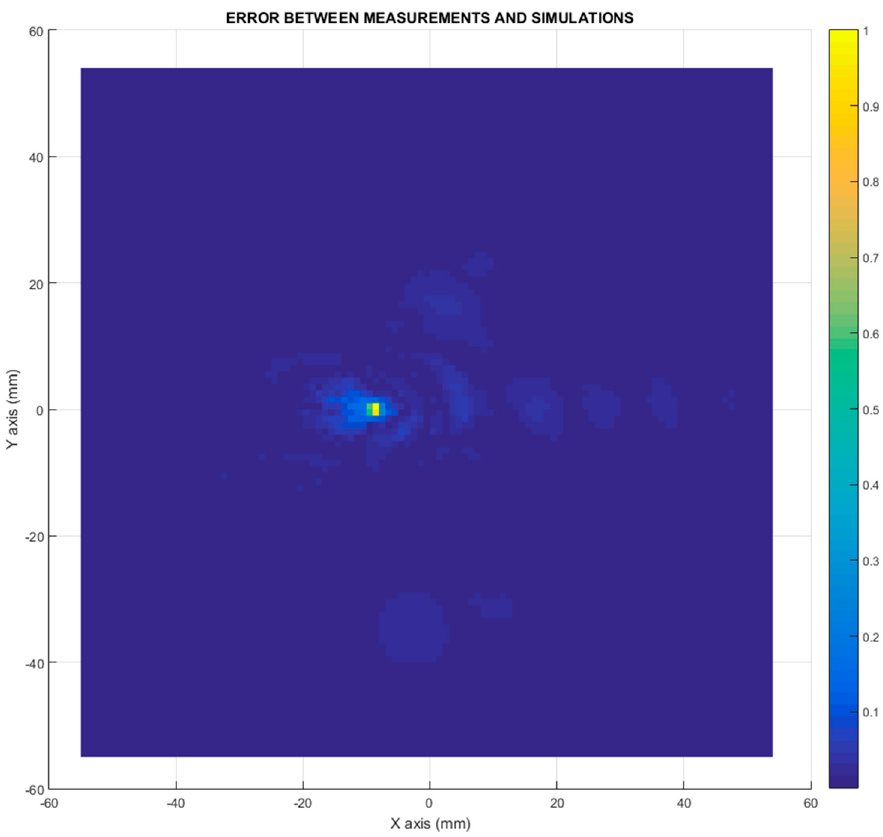
Figure 12. Error between the differential imaging measurement and the differential imaging simu- lations.